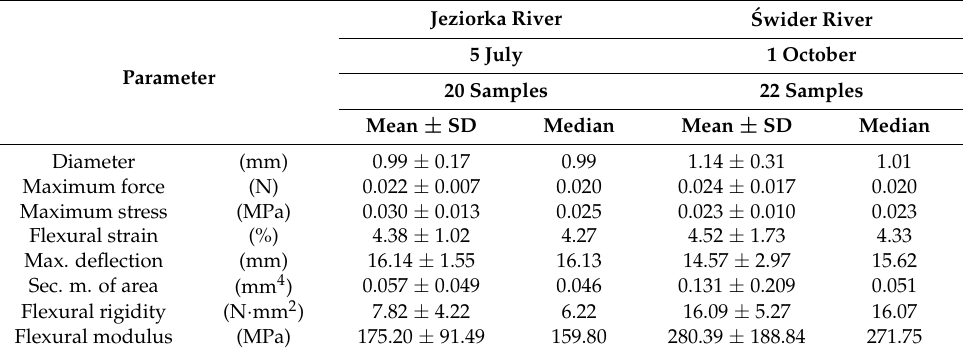
Table 6. Diameter and tension test results for P. pectinatus .